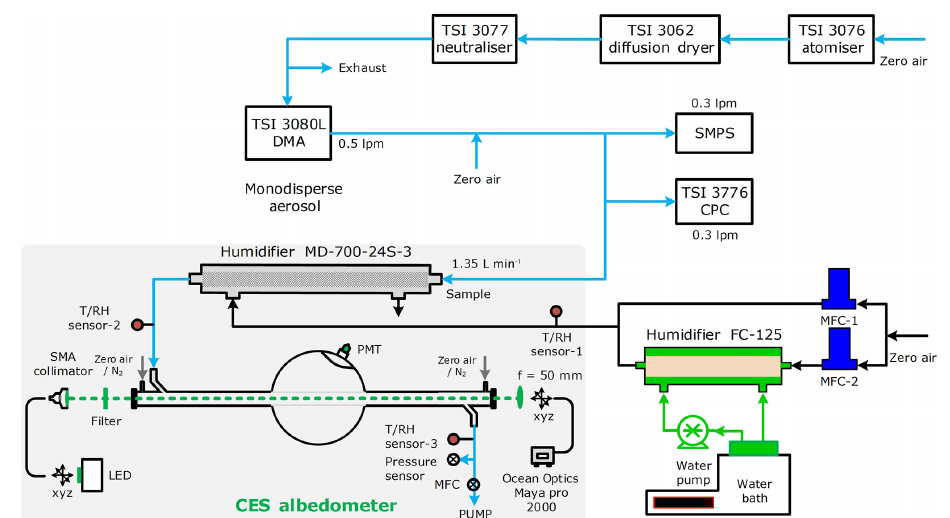
Figure 1. Schematic diagram of the humidified cavity-enhanced albedometer (H-CEA) and the aerosol-generation system. The H-CEA consists of a controllable gas humidifier system, a Nafion humidifier (MD-700, Perma Pure), and a cavity-enhanced albedometer. The relative humidity (RH) of the aerosol sample was controlled by the Nafion humidifier by adjusting the RH of the sheath gas. The sheath gas RH was controlled by adjusting the flow ratio of a dry gas stream and a wet gas stream by two mass controllers. The wet gas stream was generated using a Nafion humidifier (FC-125, Perma Pure), and a water bath was used to control its temperature. Three temperature and RH sensors were used to monitor the temperature and RH of sheath gas and aerosol samples at inlet and outlet of the cavity cell. The cyan, black, and grey lines represent the aerosol sample, humidified gas, and purging gas flows, respectively.